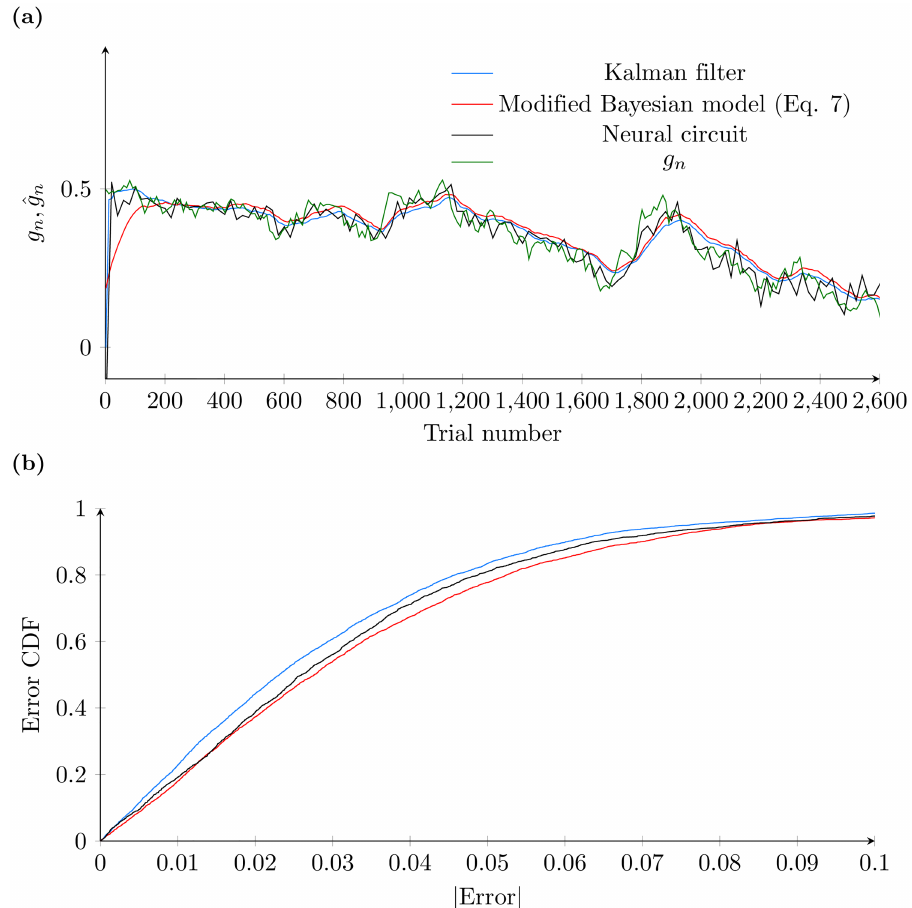
Fig 7. Comparison of real-time decision making performance by the different models. (a) Direct comparisonof the models to the true values, given by g n . To enablea direct comparisona linear map has been appliedto the result from the spiking neuralcircuit model and the value of α used in the Bayesianmodel (Eq 7) has been chosen by optimizationas describedin the main text. The green curve is for the true value of g n , the light blue curve is for the output from the Kalmanfilter, the red curve is for the Bayesian model and the black curve is for the neuralcircuit model. (b) Cumulativedistribution functions for the errors of the various methods, colors as in (a). The error distributionsare similar for all three models, althoughthe Kalman filter has the best performance.